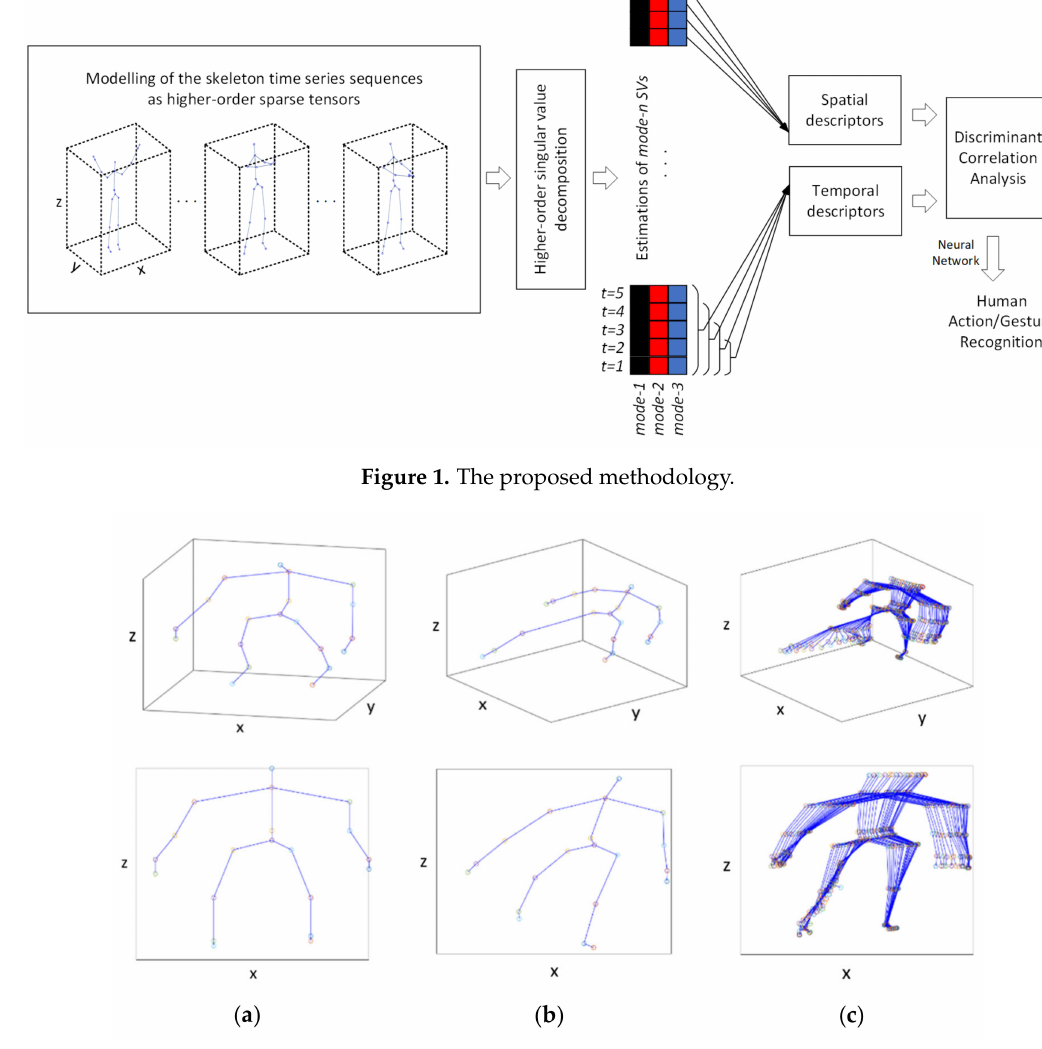
Figure 2. Tensor representation of skeleton and skeletal joints in 3D and 2D (xz-projection) graphs respectively for the extraction of spatial correlations ( a ), ( b ) and for the extraction of time-evolving correlations ( c ). Representation of skeletal joints (a) in the initial position, ( b ) in the position of right kick and ( c ) for the period from the initial position to right